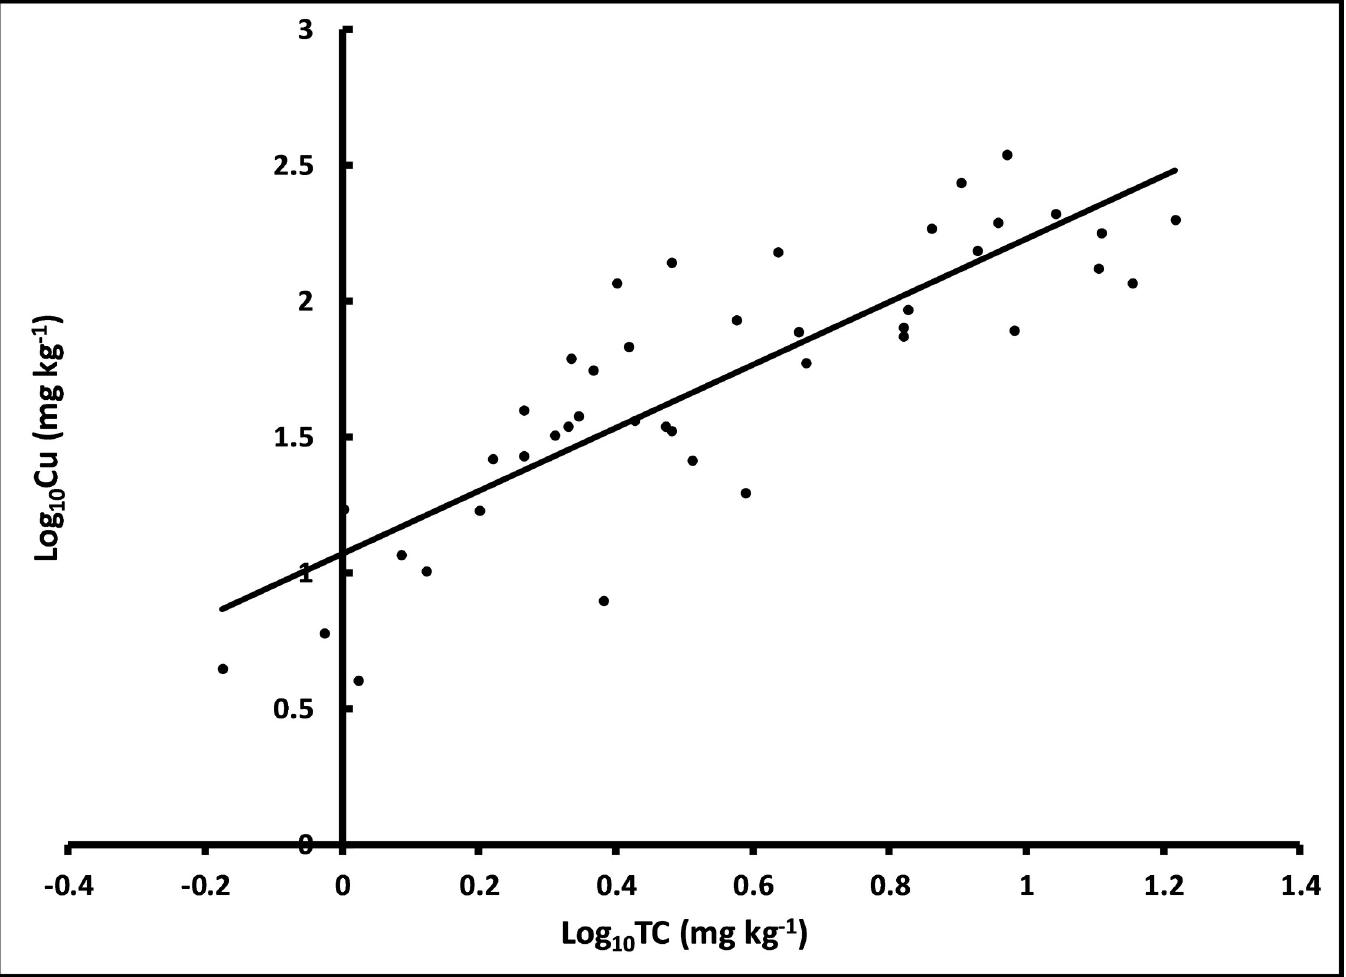
Fig 1. Relationship between log 10 TC and log 10